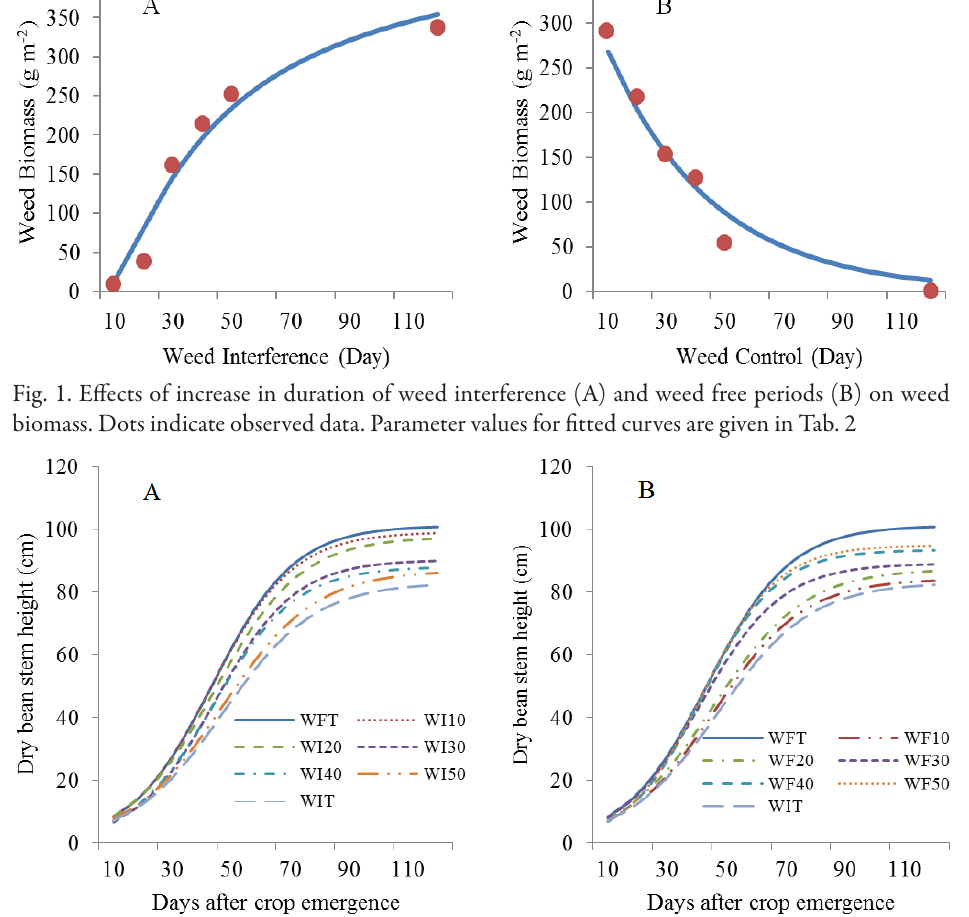
Fig. 2. Effects of increase in duration of weed interference (A) and weed free periods (B) on dry bean